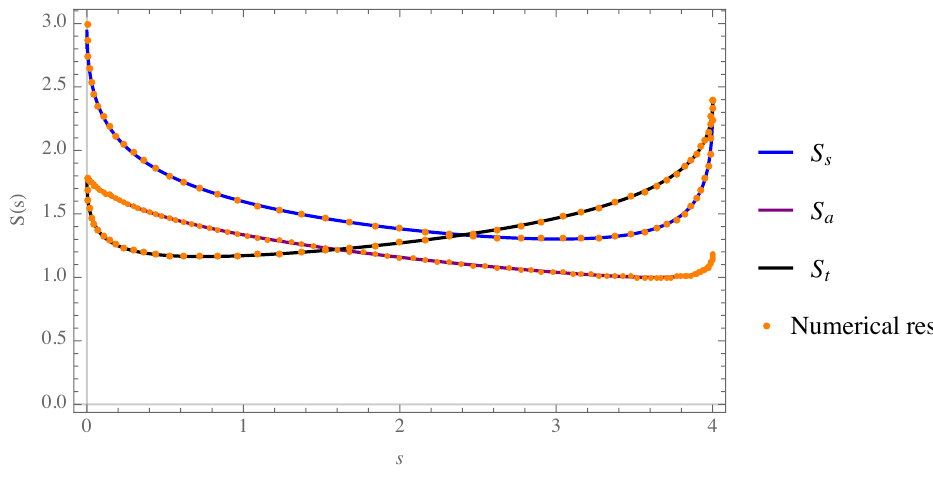
Figure 3 . Comparision of the numerical S -matrix with the analytical sine-Gordon matrix with (cid:25) = 2 : 5. We have subtracted the pole structure in S ( s ) for a cleaner plot. (cid:24)